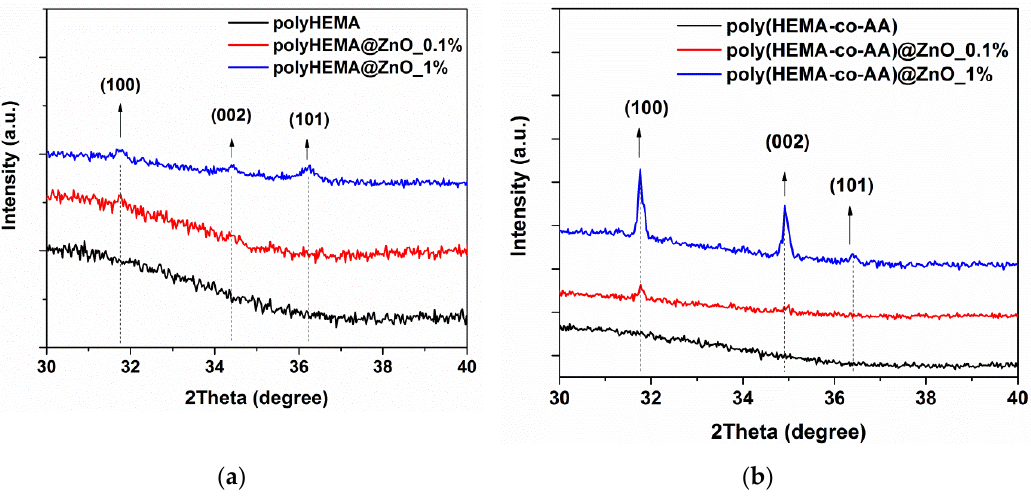
Figure 12. XRD pattern of ( a ) polyHEMA@ZnO and ( b ) poly(HEMA-co-AA)@ZnO samples at the end of the release study. Arrows indicate the diffraction peaks belonging to wurtzite ZnO phase.